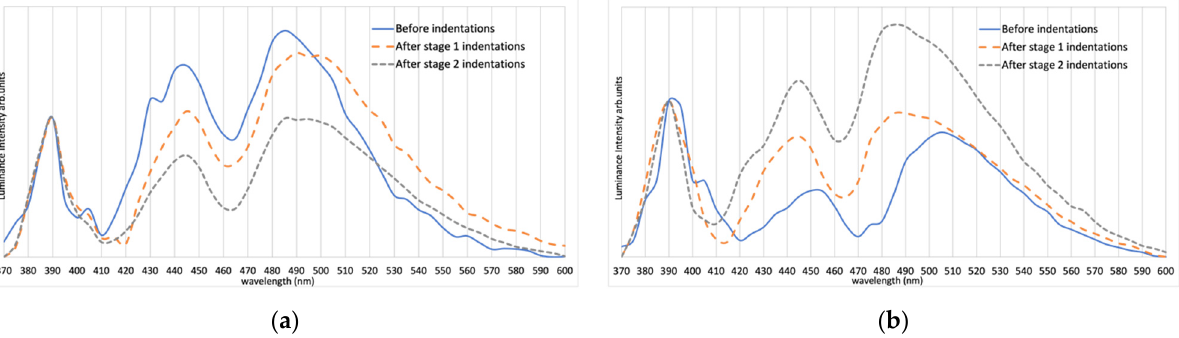
Figure 9. Spectrum of Samples 1 ( a ) and 2 ( b ) before and after indentation at each stage (normalized at 390 nm ).